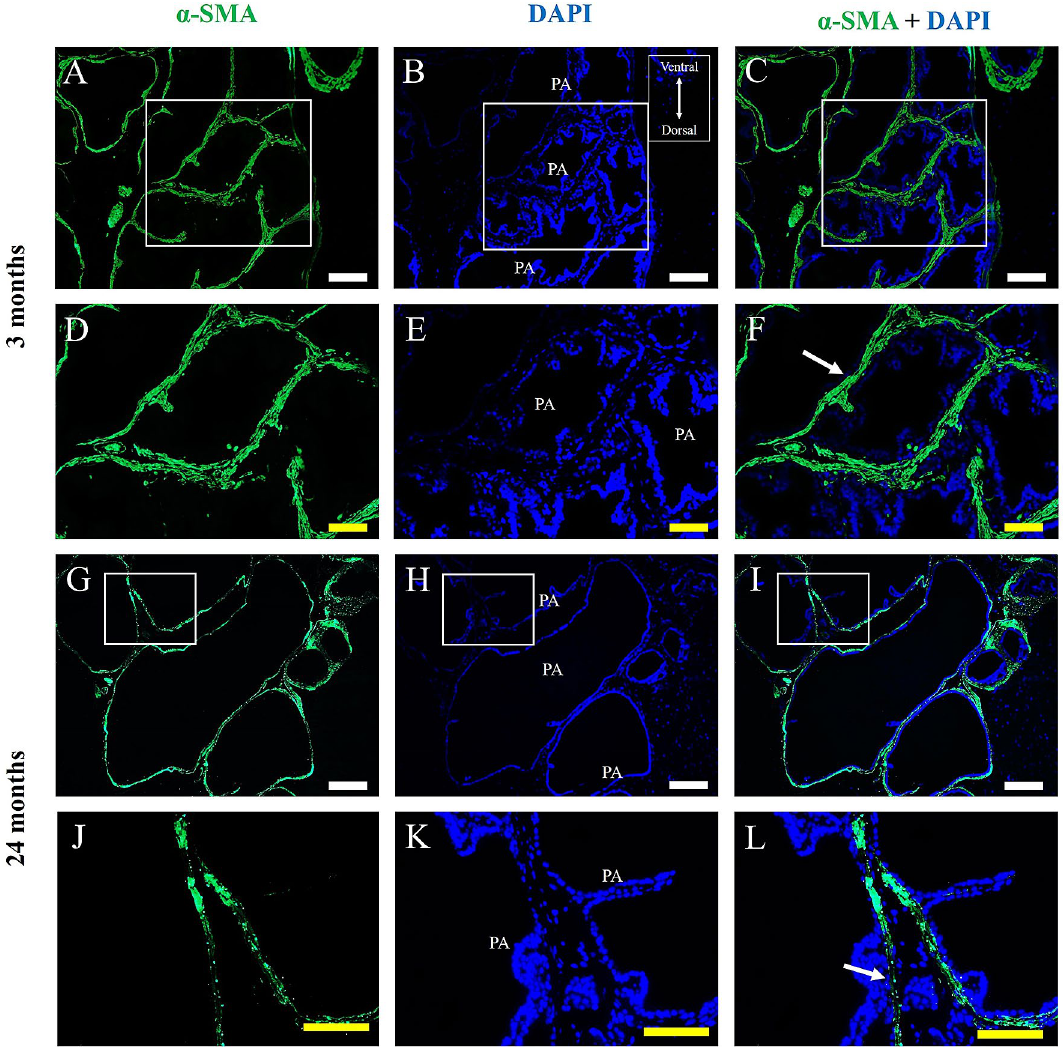
Figure 4. Immunofluorescence assays for α-SMA in prostate histological sections of adult (3 months old) and senile (24 months old) male Mongolian gerbils. ( A – F ) A thick layer of smooth muscle cells, labeled for α-SMA, surrounds the prostate alveoli. ( G – L ) The layer of smooth muscle cells that surrounds the alveoli becomes thinner. PA (Prostate alveoli), Arrow (Detail of smooth muscle layer), White bar (100 µm), Yellow bar (50